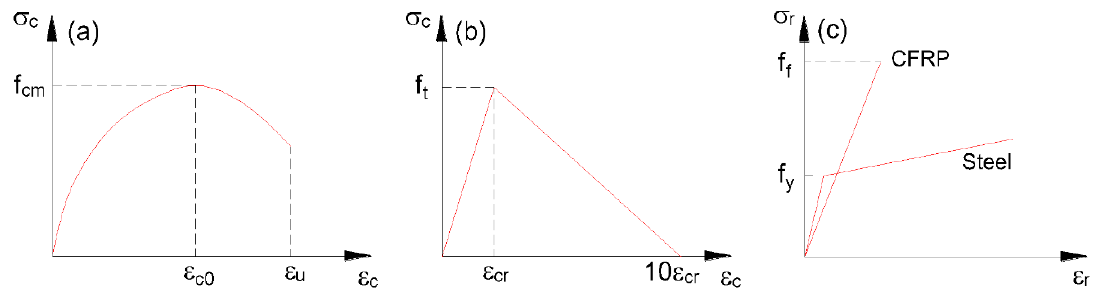
Figure 1. Stress – strain curves of materials. ( a ) Concrete in compression; ( b ) concrete in tension; ( c ) reinforcement bars.